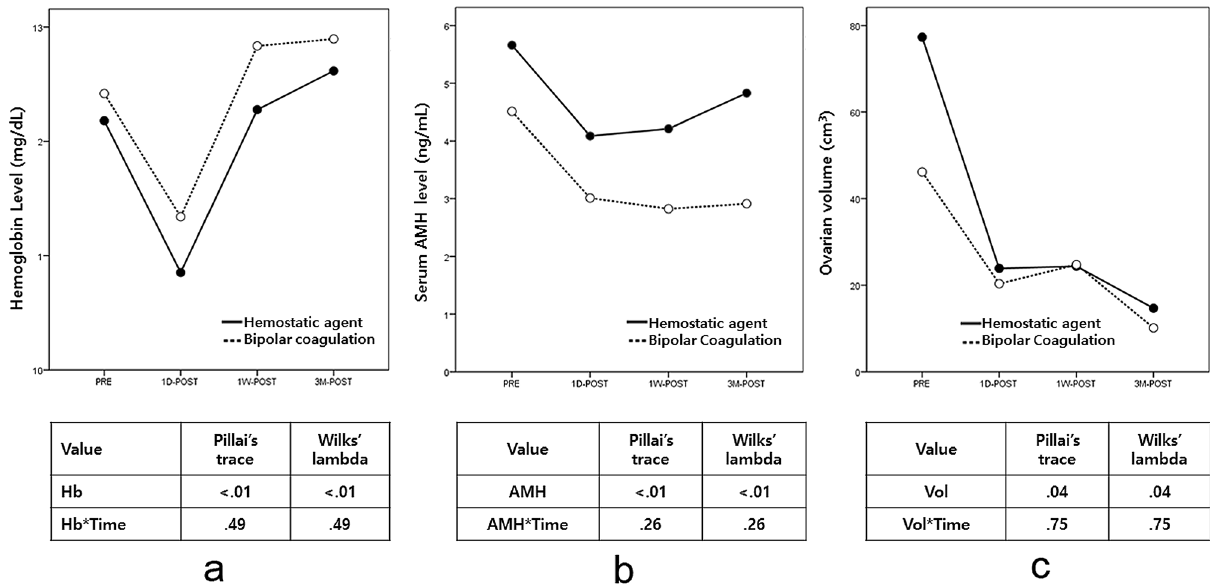
Figure 2. Repeated measure analysis of variance for comparing variables over time ( a ) hemoglobin (Hb) levels ( b ) anti-Müllerian hormone (AMH) levels ( c ) ovarian